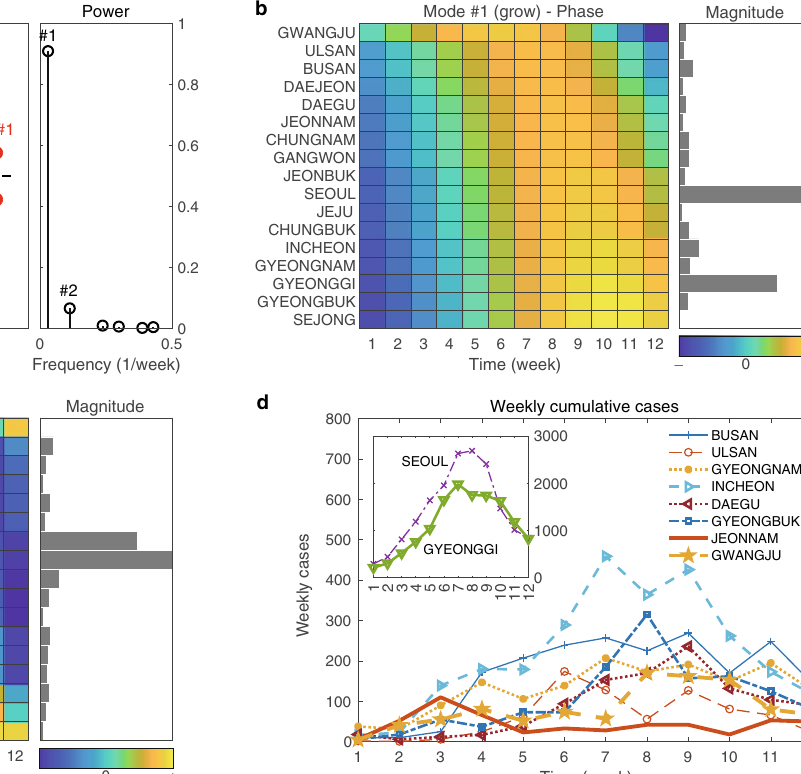
Figure 5. The third wave: DMD eigenvalues and modes. ( a ) shows eigenspectrum { (cid:31) j } j = 1, ··· in the left and p |� α j φ j � F } j = 1, ··· , in the right. The first two DMD modes of highest powers are enumerated powers, defined as {| (cid:31) j as #1 and #2 . ( b ) and ( c ) show the phase and magnitude of the #1 and #2 DMD modes, respectively. In the phase diagram, regions, whose phases are similar are gathered. ( d ) is the time series for weekly cumulative cases for some selected regions.